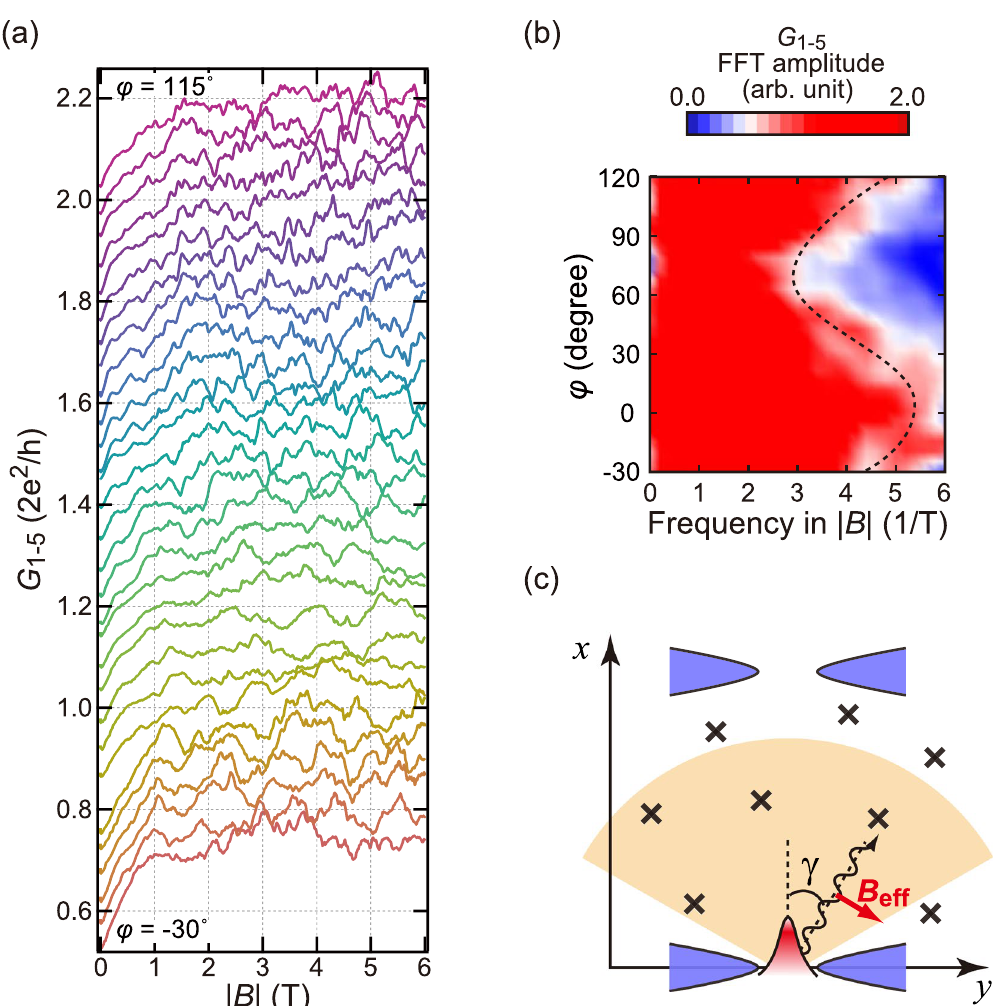
Figure 4. Effect of azimuth angle in the magnetic field on the conductance fluctuation. ( a ) Conductance fluctuation in G 1–5 at 150 mK versus the magnetic field amplitude | B | for different azimuth angles ϕ from − 30° (bottom) to 115° (top). The step in ϕ and the offset in G 1–5 are 5° and 0.05 G q , respectively. ( b ) FFT amplitude spectrum of the conductance fluctuation plotted against | B | ranging from 1.5 to 6 T and ϕ . The broken line represents the smoothed ϕ -tendency given in equation (5). ( c ) Schematic of an electron path. Electrons transit over the fan-like beige